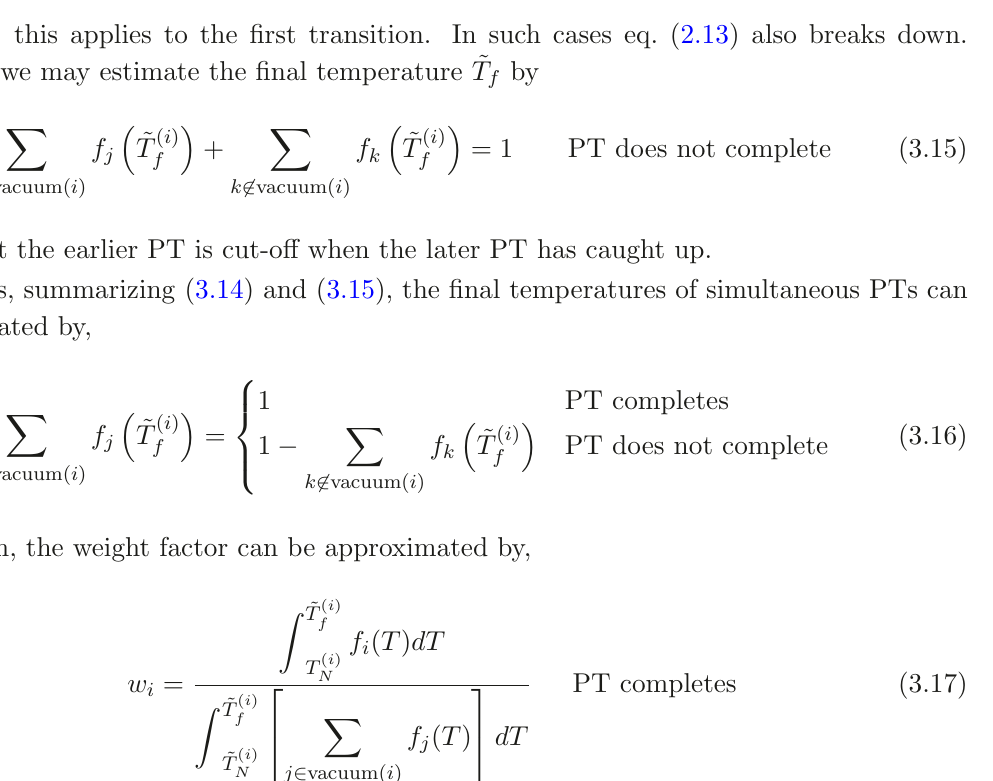
Figure 3 . Example of relative weight factors for two nucleation scenarios of the same